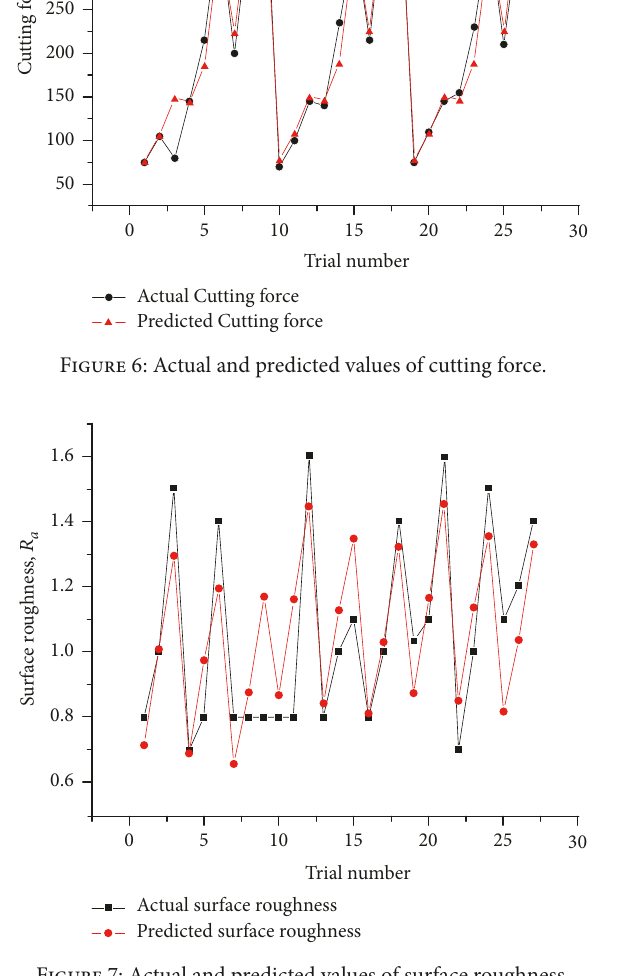
Figure 7: Actual and predicted values of surface roughness. Table 7: Confirmation tests for cutting forces.